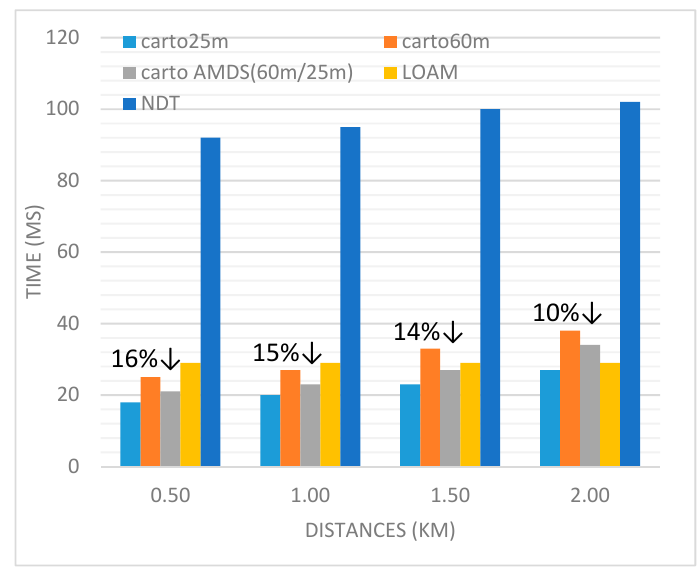
Figure 12. Average speed performance comparison.